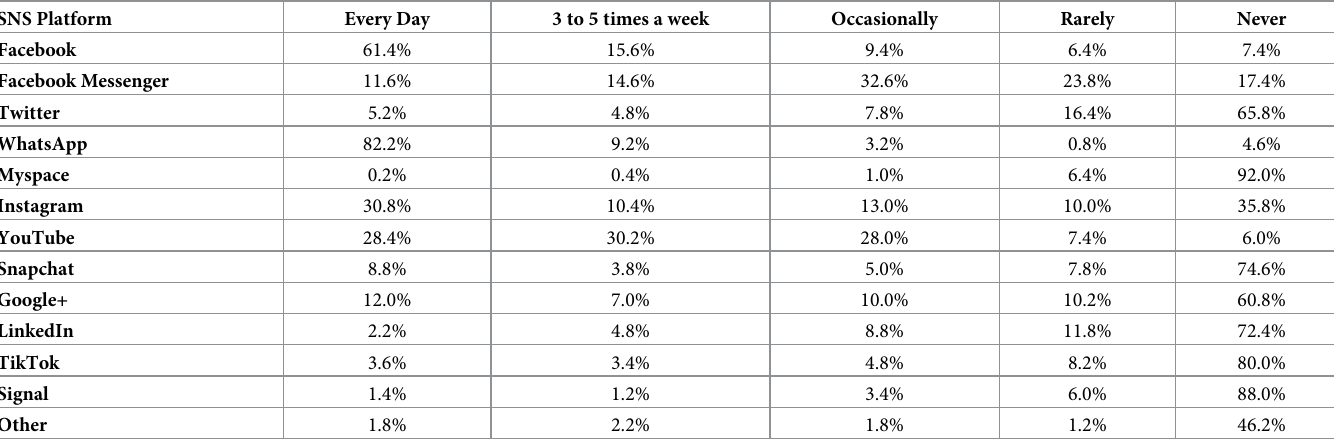
Table 5. SNS platforms and the frequency of using each platform reported in Study